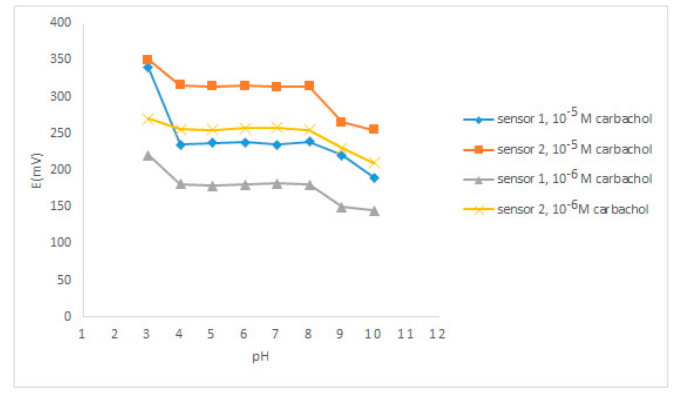
ff ect of pH on the response of the proposed Figure 5. Effect of pH on the response of the proposed sensors. Figure 5. E